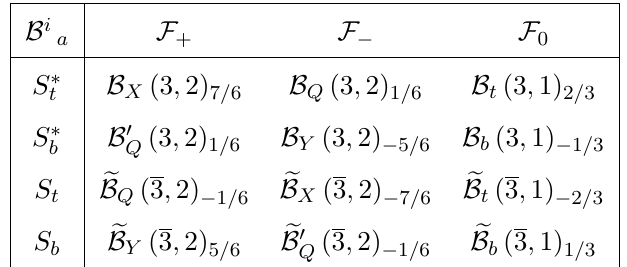
Table 2 . Representations of the composite partners under the SM gauge group. The rows and columns correspond to the fundamental TC-scalar and TC-fermion constituents,